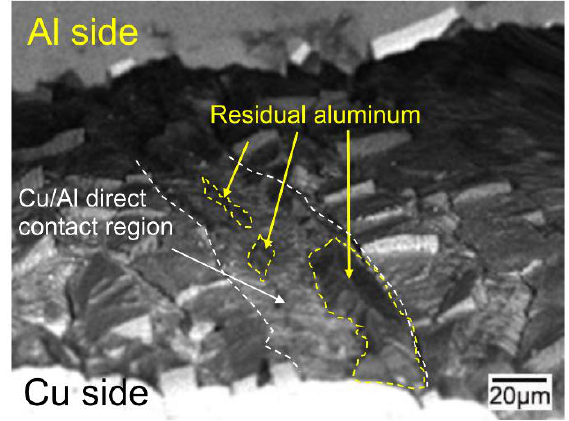
Figure 16. Peeled surface morphology (BSE image) of the Cu/Al clad sheet with a thickness of 3 mm after multi-pass rolling (Cu side).